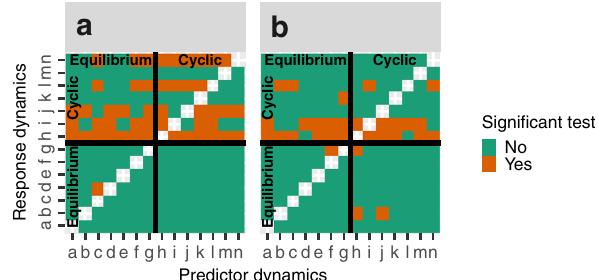
Fig. 3 Detecting alternative dynamical attractors in an experimental data set 7 . This fi gure shows if there is signi fi cant difference in across ( j ^ Y i j M j ð t Þ (cid:2) Y i ð t Þj ) and within regime prediction errors ( j ^ Y i j M i ð t Þ (cid:2) Y i ð t Þj ) across each combination of 14 experimental time series (a( n = 87), b ( n = 63), c( n = 75), d( n = 77), e( n = 16), f( n = 94), g( n = 90), h( n = 114), i ( n = 120), j( n = 41), k( n = 18), l( n = 49), m( n = 21) and n( n = 47); Supplementary Figs. 4 – 11). These time series were earlier classi fi ed as either equilibria or cycles 7 ; a classi fi cation which is here displayed by black thick lines. Signi fi cant, and non-signi fi cant, tests are illustrated in orange, and green, respectively (H0: j ^ Y i j M i (cid:2) Y i j > j ^ Y i j M j (cid:2) Y i j ; permutation test; p = 0.05). Indexes ( i, j ) refer to row i and column j in the grids. Subpanels show cases where ( a ) Brachionus calyci fl orus , and ( b ) Chlorella vulgaris , time series are used to predict Chlorella vulgaris , and Brachionus calyci fl orus , time series, respectively (See “ Methods ” ).